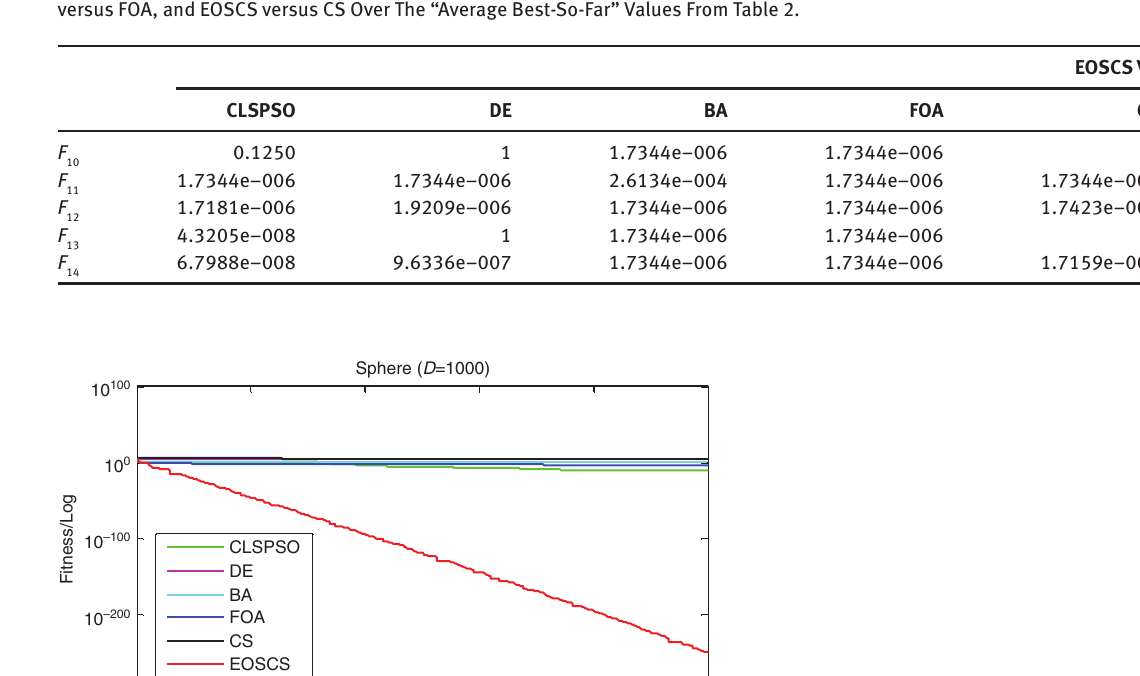
Figure 15: Convergence Curves for F